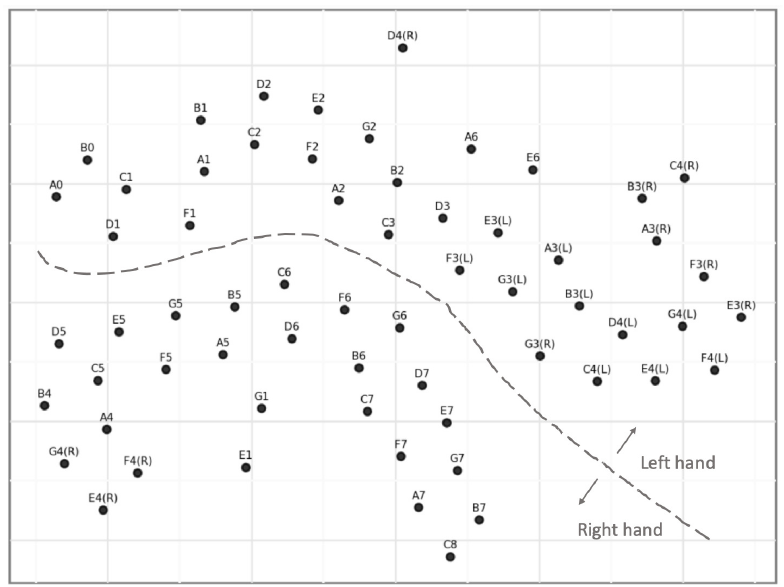
Figure 9. A t-SNE plot of the AWD-LSTM embeddings for bootleg score features containing a single notehead. Note that some notehead positions in the middle register may appear in either the left - hand staff or right -hand staff. With only a few exceptions, the notes cluster by left hand ( upper right ) and right hand ( lower left )